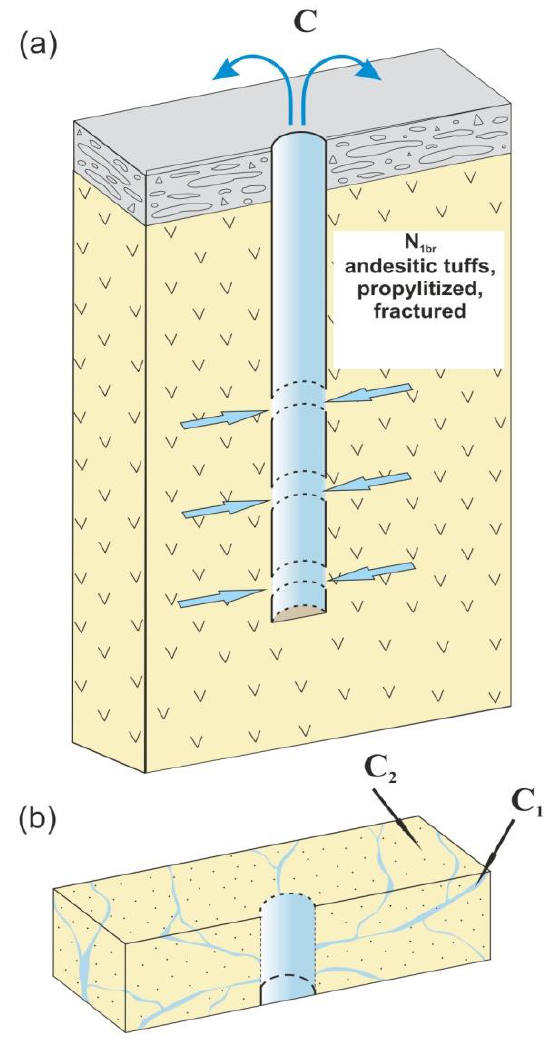
Figure 8. Diagrams of well M-1 ( a ) and aquifer as a medium with double porosity ( b ). Dashed lines in Figure ( a ) show the perforation sections of wellbore, horizontal arrows indicate the flow of mixed water into the wellbore, C—concentration of IC in mixed water flowing from the well; In Figure ( b ) shows C 1 —concentration of IC in water from “fissures”, C 2 —concentration of IC in water from